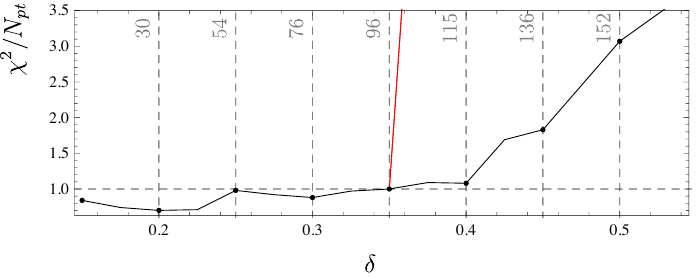
Figure 5. Comparison of χ 2 /N pt for different values of δ . The fits are made for SIDIS+DY at N 3 LO setup. Gray numbers at the top of the figure show the number of points. At δ = 0 . 375 the additional point of π -induced DY contributes with a very large χ 2 (red line). For δ > 0 . 375 only SIDIS points are